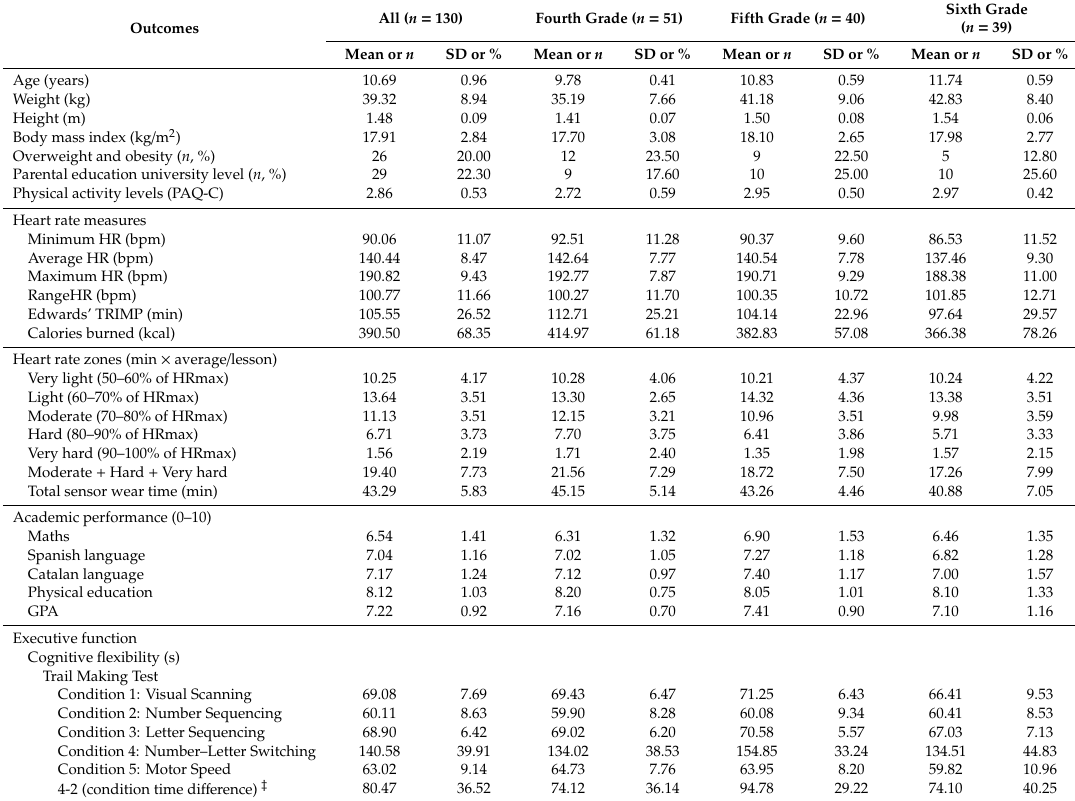
Table 1. Descriptive characteristics of the study sample ( n =